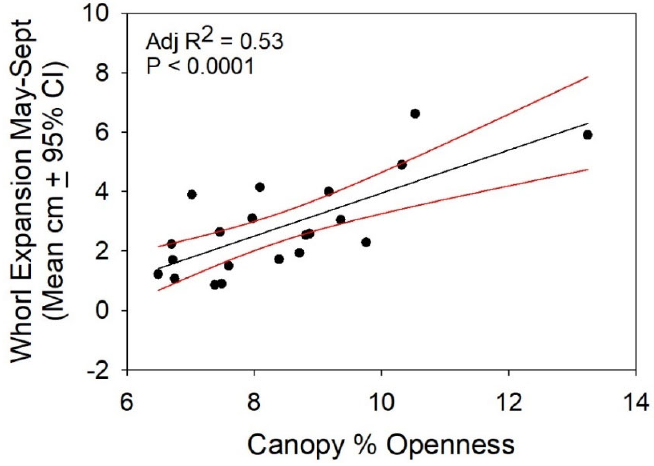
Figure 6. Within ‐ year colony mean whorl expansion as a function of canopy openness. Each point is the mean for a population in a year. The red lines indicate 95% confidence intervals about the regression of whorl expansion on canopy openness. Plants that were growing at sites with more light grew more between May and September.